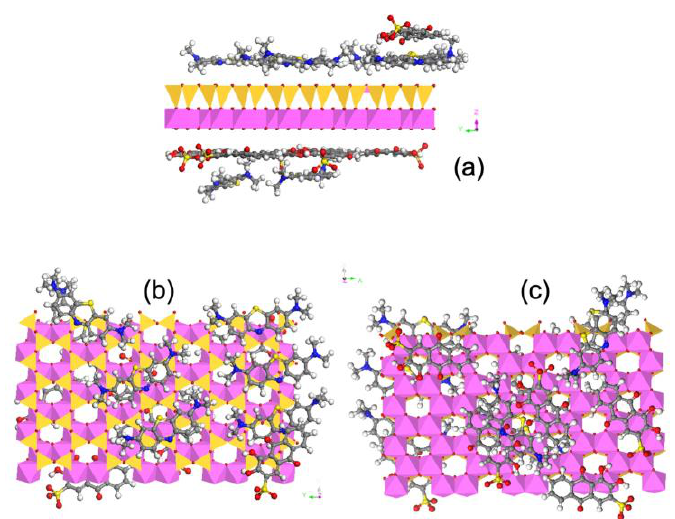
Figure 8. A molecular dynamic simulation showing ARS and MB sorption from a mixed solution on the ab plane projected along the a direction ( a ) and c direction on the SiO 4 tetrahedral sheet ( b ) and the Al(OH) 6 octahedral sheet ( c ). See Figure 7 for a detailed color notation of the different atoms.